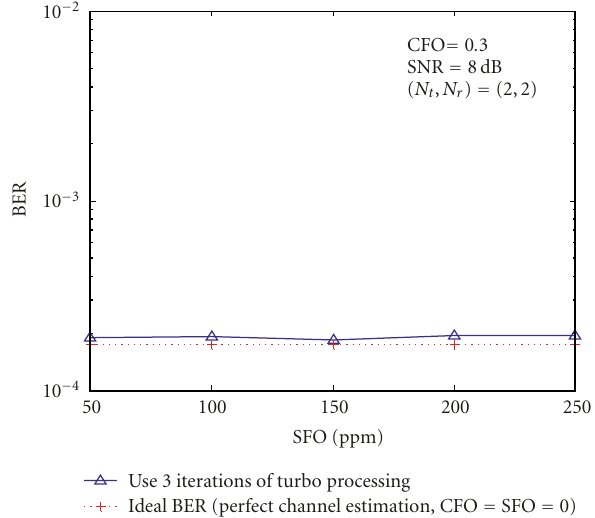
Figure 9: BER performance of the proposed turbo joint channel estimation, synchronization, and decoding scheme under various SFO values.